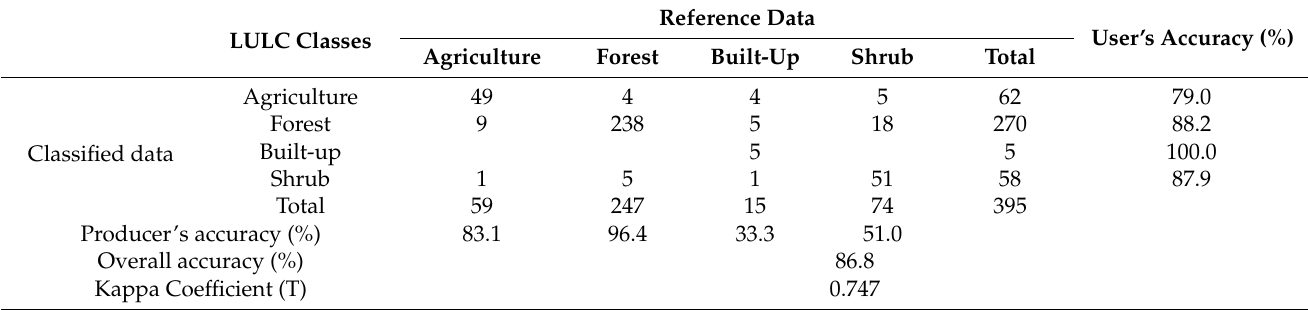
Figure 8. Land use pictures taken in the study area: ( a ) shrubs in the western highlands part of Viti Levu, ( b ) agriculture conversion for sugar cane plantation in the Ba Province, ( c ) the forest clearance for small ‐ scale farming in the central division, and ( d ) vicinity of the typical Fijian village set up with subsistence farming for food security outside the village boundary (Source of photographs: personal documentation). Table 3. Confusion matrix of land use classification in 2000.